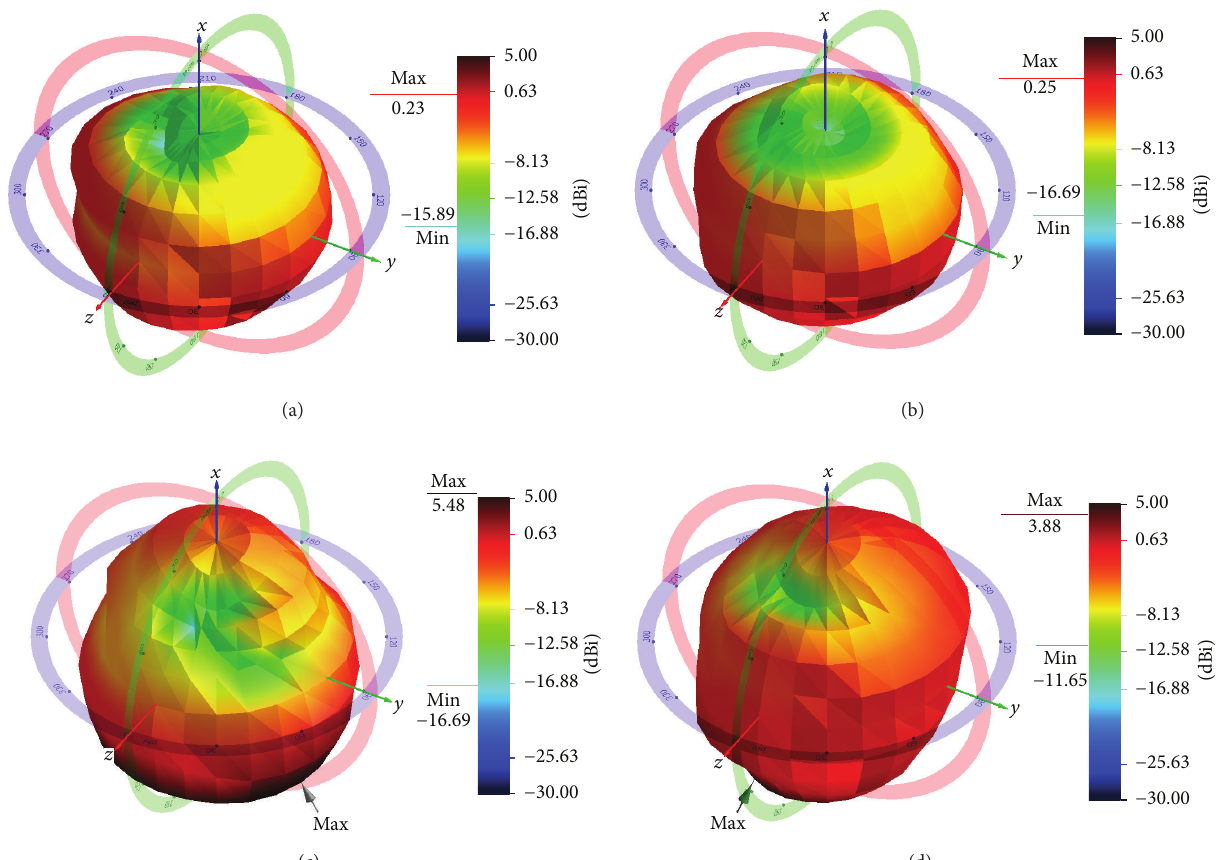
Figure 10: Measured 3D radiation patterns of the fabricated antenna at (a) 828 MHz, (b) 902 MHz, (c) 1850 MHz, and (d) 2680 MHz.